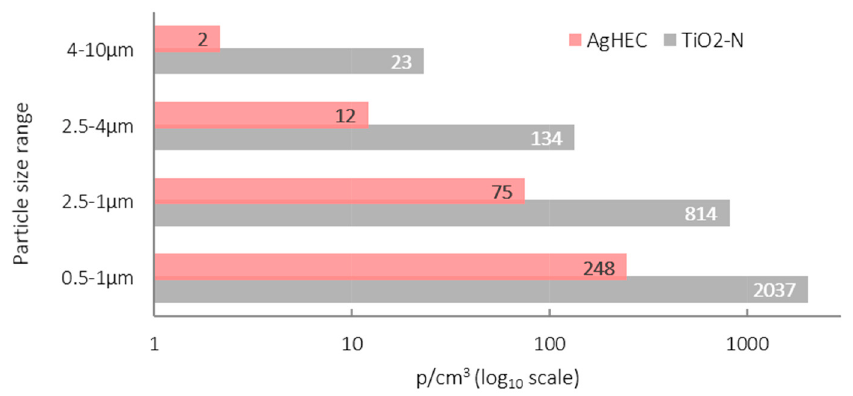
Figure 3. Histogram of the particle number concentration in different size classes measured in the spray chamber. Averaged SPS30 outputs. TiO 2 -N suspension (grey), AgHEC suspension (pink).